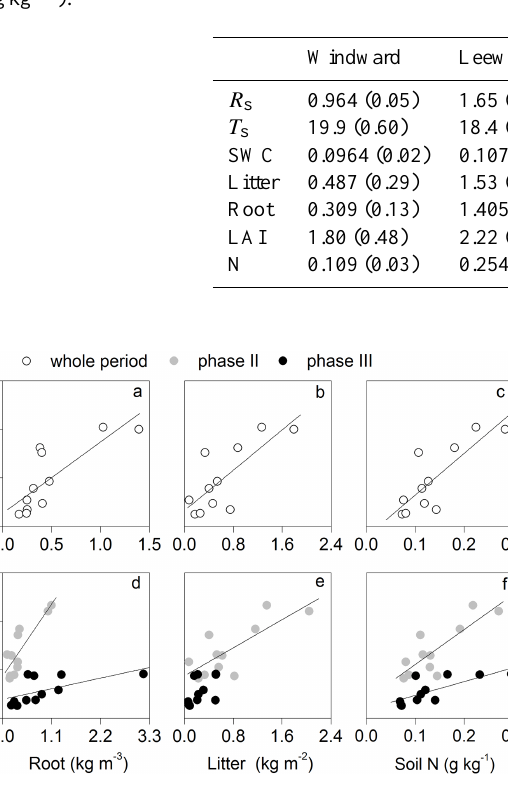
Figure 4. Relationships between soil respiration ( R s ) and root biomass, and litterfall and soil nitrogen over the measurement pe- riod (open circles) and during flower-bearing (phase II; gray cir- cles) and leaf coloration–defoliation (phase III; black circles) phase. Lines are linear regressions with p < 0 . 05. Equations, R 2 , and p values are given in Table 3.